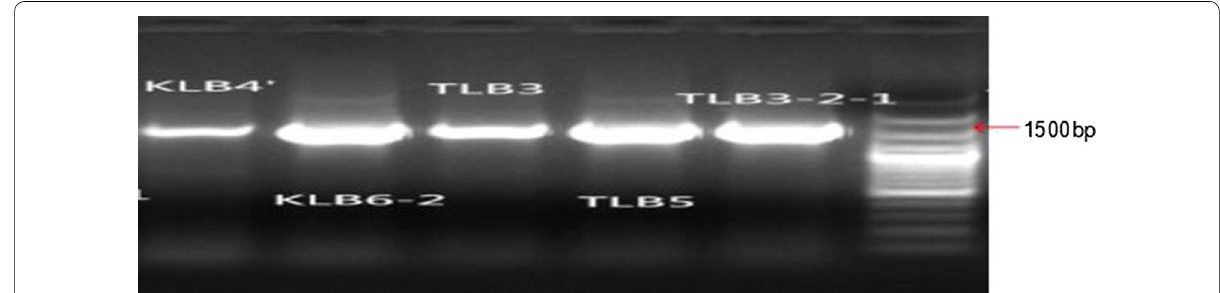
Fig. 1 The agarose electrophoresis of five endogenetic strains 16S rRNA gene products. K and T represent the kinds of medium, K is the abbreviation of King‘s B medium; T is the abbreviation of Tryptic soy agar medium. From left to right is K LB4, KLB6-2, TLB3, T LB5, TLB3-2-1, and maker